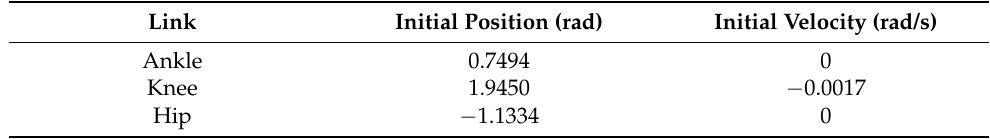
Table 4. Initial joint parameters in